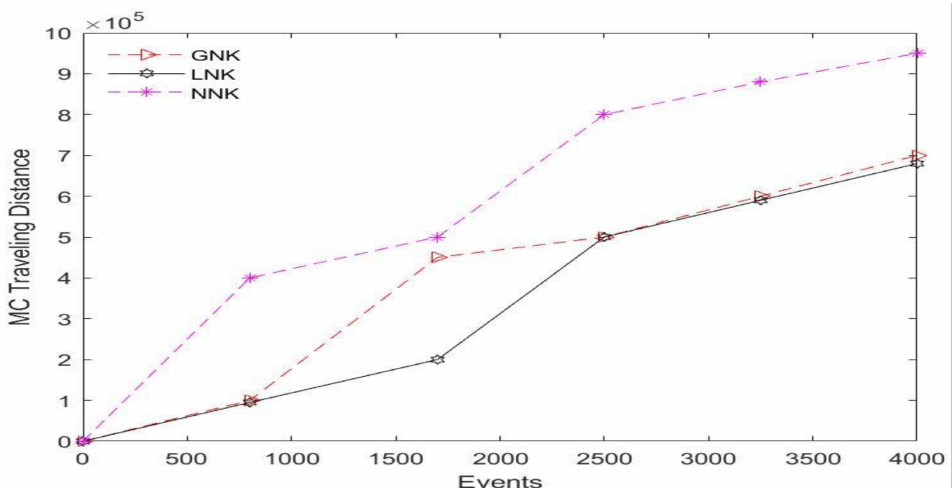
Figure 9. Distance travelled by MCs for non-uniform